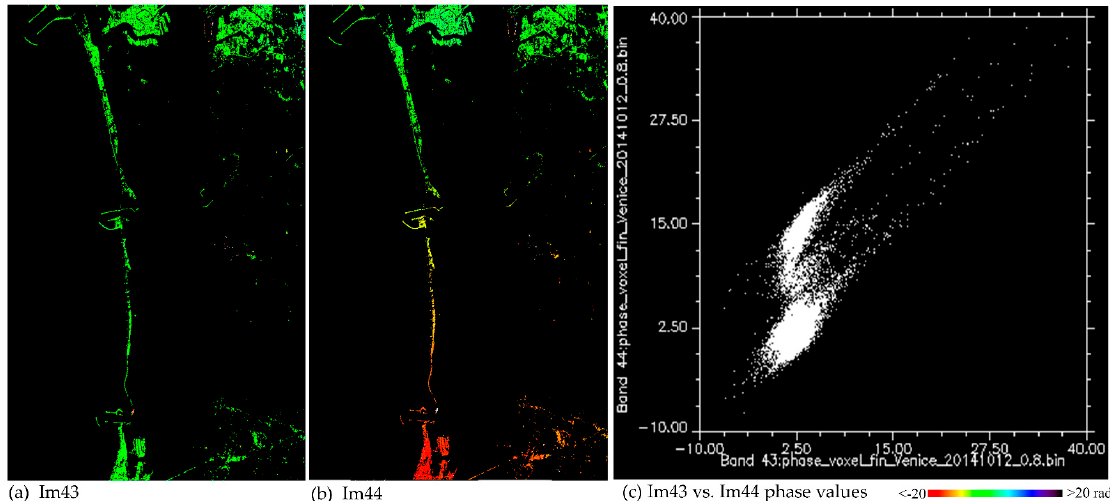
Figure 3. Subsets of processed images of cumulative phases with different scores (in radar geome- try): image 43 classified in C1 (a) and image 44 classified in C3 (b). The scatter plot in (c) is ob- tained from phase information of image 43 (horizontal axis) and image 44 (vertical axis).